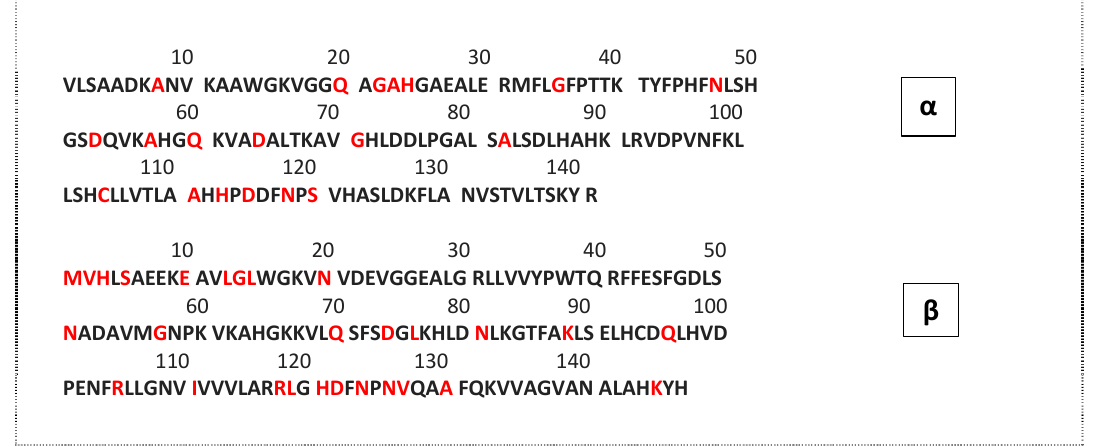
Figure 5. Amino acid sequence of porcine hemoglobin, α chain and β chain. Adapted from UniProtKB, Code: HP beta P02067, HP alpha P01965, HB beta P02070 and HB alpha P01966 [44]. Red amino acids are different in the bovine hemoglobin sequence. Table 3. Potential antimicrobial peptides from the porcine cruor hydrolysate.